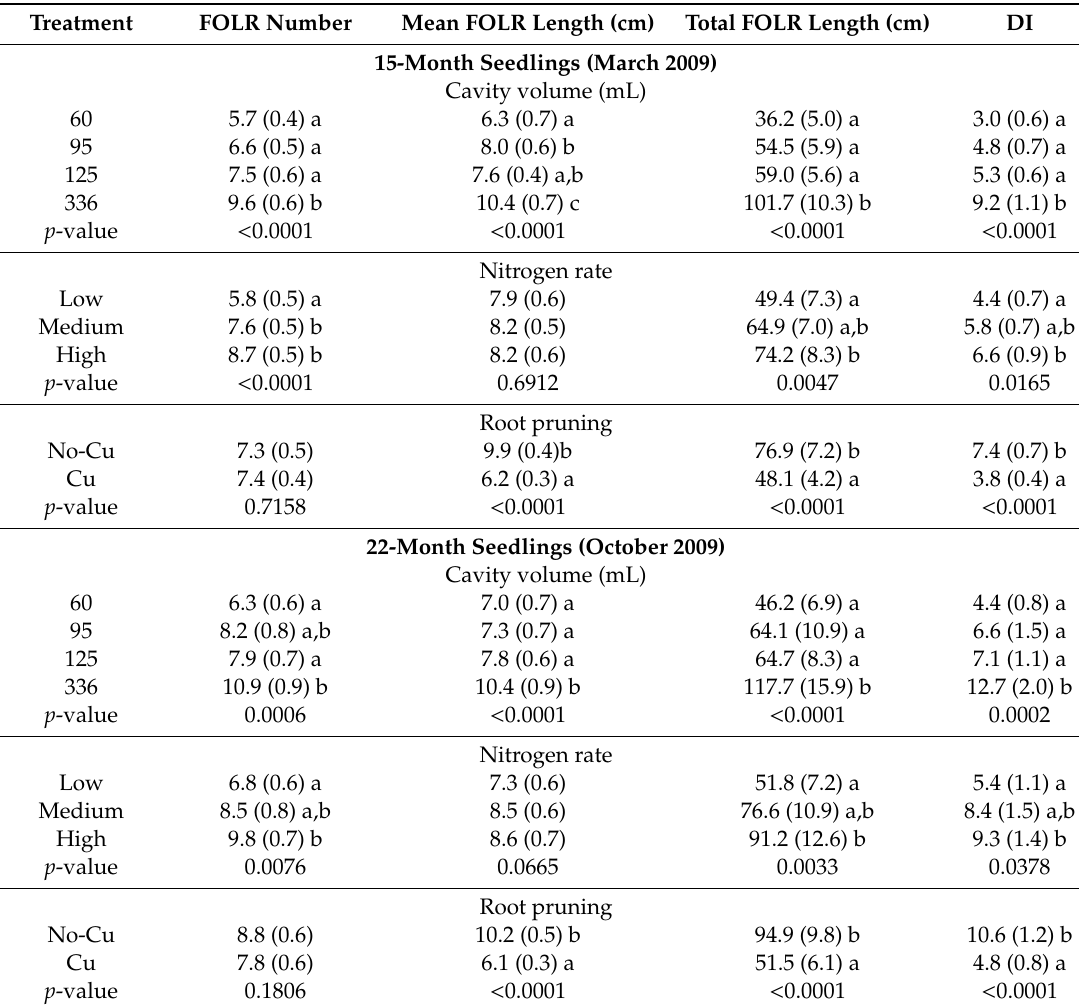
Table 7. Means (1 SE) and p -values for morphological variables of the first-order lateral roots (FOLR) within the root plug in response to nursery treatments for seedlings excavated 15 and 22 months after outplanting. The morphological variables are as follows: FOLR number; mean FOLR length, average length of FOLR within the root plug; total FOLR length, sum of lengths of FOLRs within the root plug; and DI, deformity index, the sum of deformity scores for FOLR within the root plug. Within each treatment and excavation, means followed by the same letter are not significantly di ff erent at the Bonferroni-adjusted 0.05